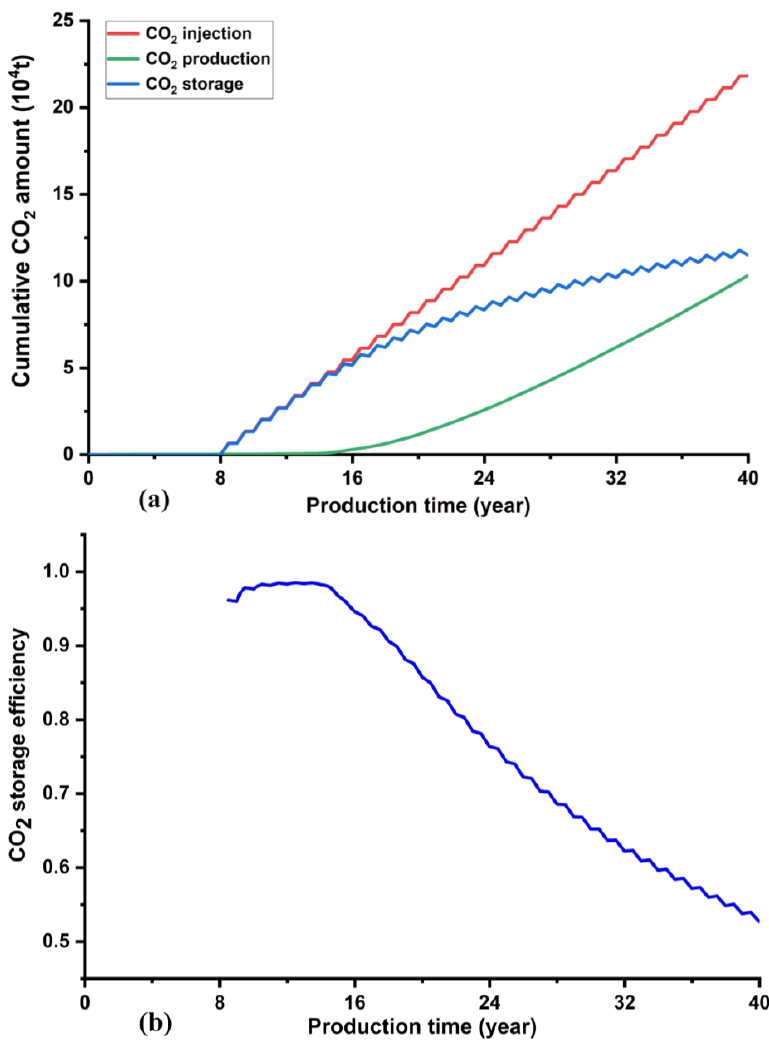
Figure 6. CO 2 storage in the production process: ( a ) injection, production and storage amount of CO 2 , and ( b ) CO 2 storage CO 2 , and ( b ) CO 2 storage efficiency.